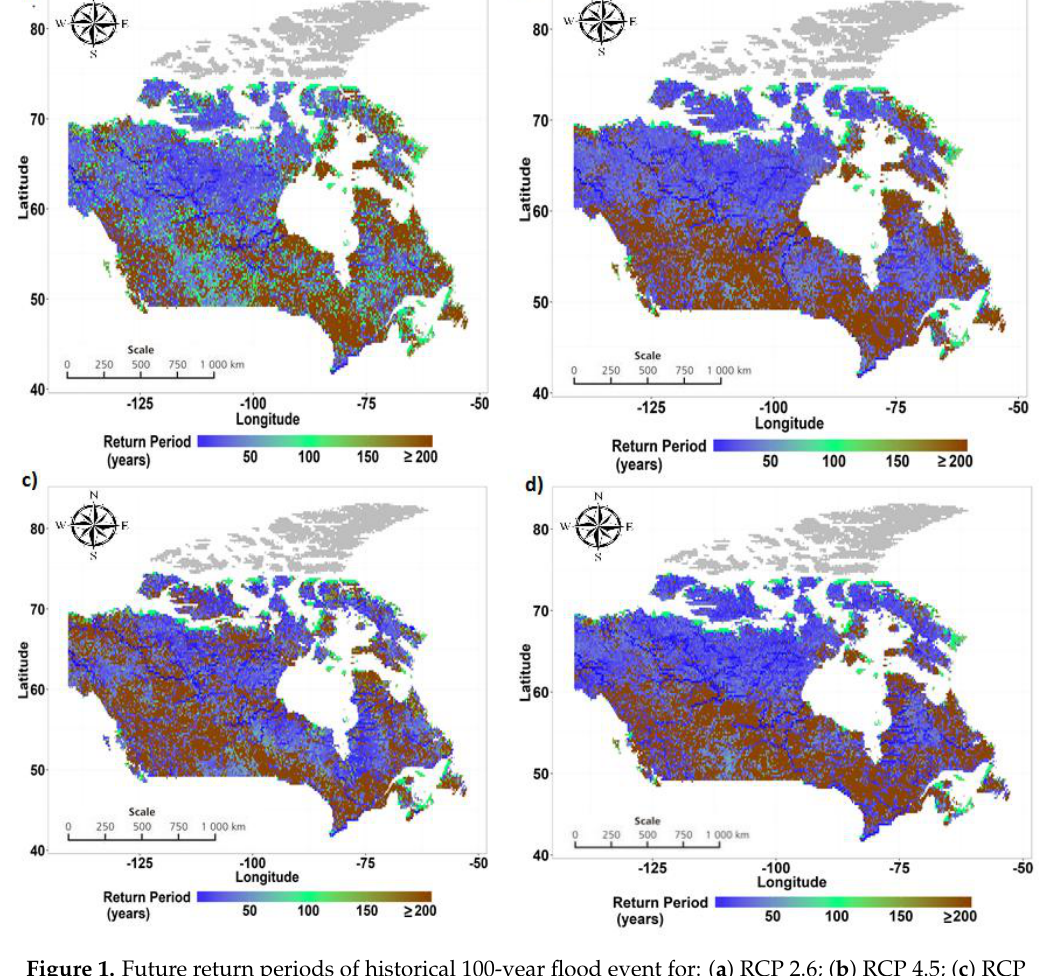
Figure 1. Future return periods of historical 100-year flood event for: ( a ) RCP 2.6; ( b ) RCP 4.5; ( c ) RCP 6.0; and ( d ) RCP 8.5. The results presented are GCM projections aggregated using the robust GCM median approach.